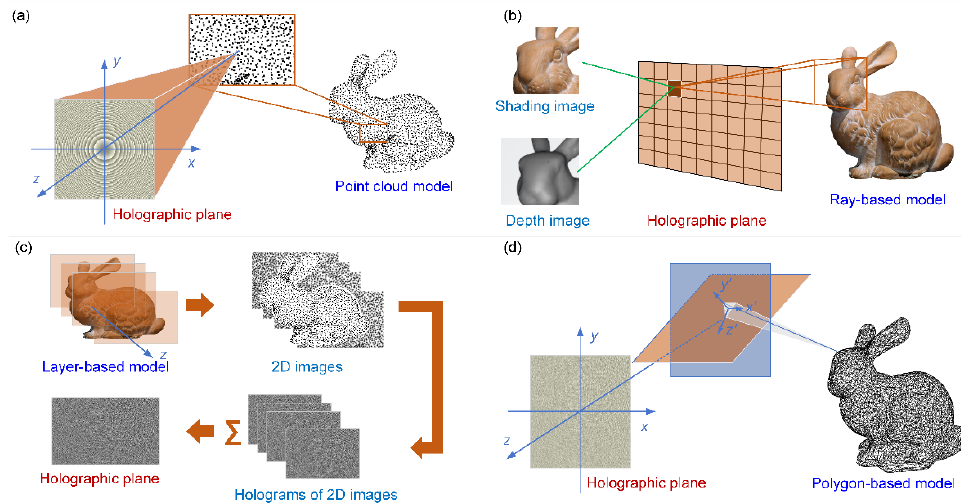
Figure 1. Hologram synthesis from different primitives: ( a ) point − based CGH method; ( b ) ray − based CGH method; ( c ) layer − based CGH method; and ( d ) polygon − based CGH method. CGH method; ( c ) layer–based CGH method; and ( d ) polygon–based CGH